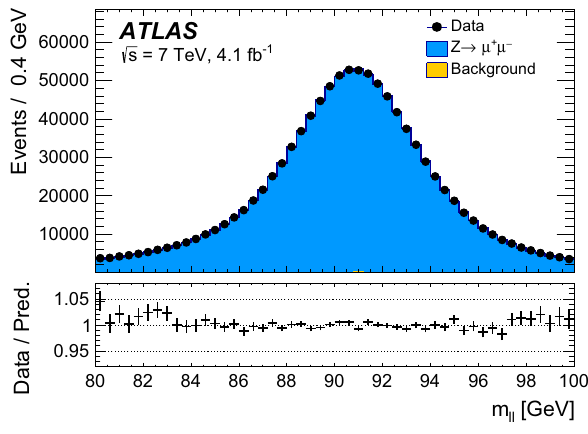
Fig. 6 Dimuon invariant mass distribution in Z → μμ events. The data are compared to the simulation including signal and background contributions. Corrections for momentum scale and resolution, and for reconstruction, isolation, and trigger efficiencies are applied to the muons in the simulated events. Background events contribute less than 0.2% of the observed distribution. The lower panel shows the data-to- prediction ratio, with the error bars showing the statistical